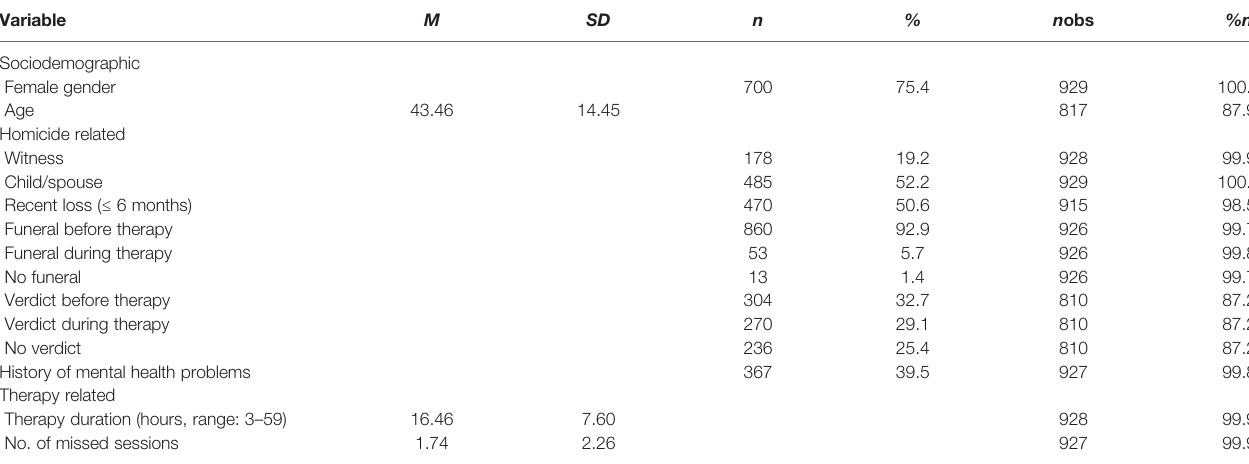
TABLE 1 | Sociodemographic characteristics, homicide characteristics, history of mental health problems and therapy characteristics at baseline. Variable